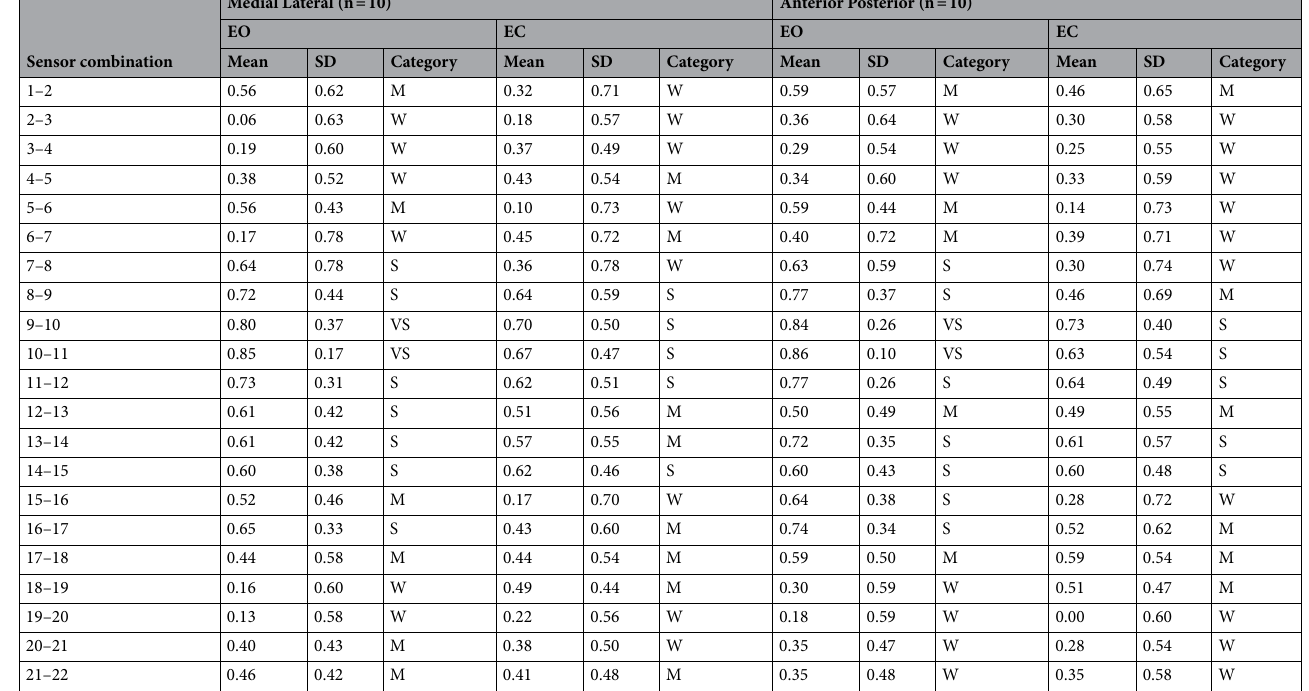
Table 2. Instantaneous phase synchronization between sensors (APLV). The mean instantaneous phase synchronization degree and category between each sensor are shown for each condition. APLV: average phase locking value, VS: very strong, S: strong, M: moderate, W: weak, SD: standard deviation, EO: eye-opening condition, EC: eye-closing